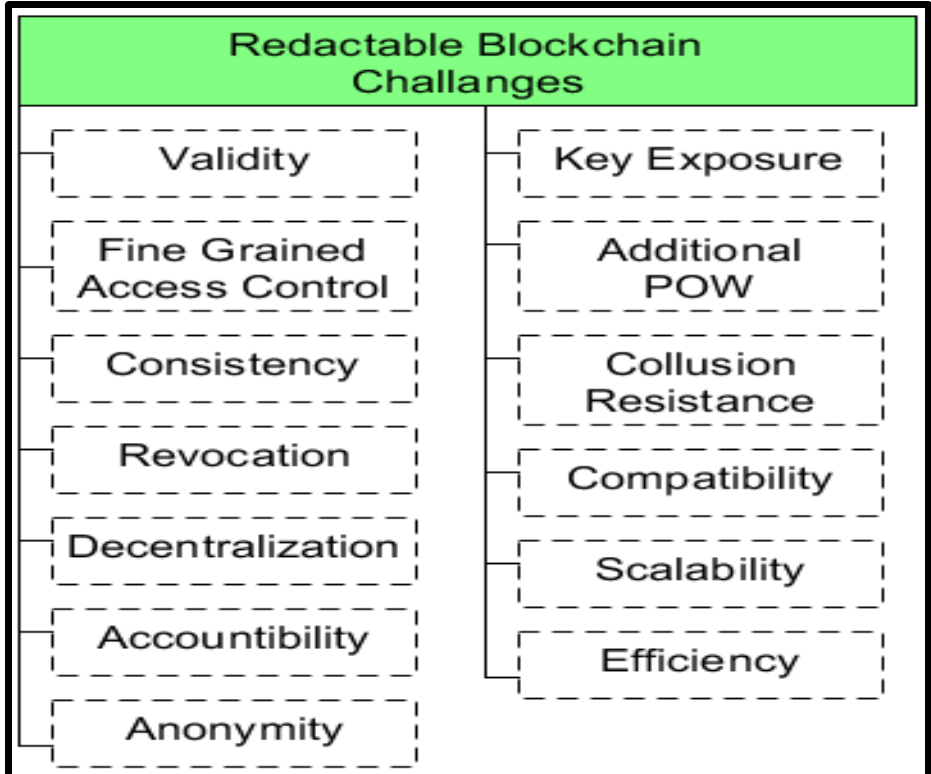
Figure 3. Redactable blockchain implementation challenges.